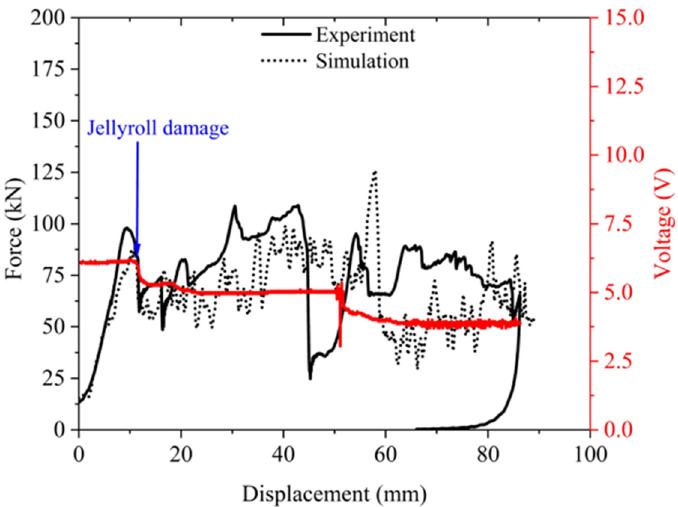
Figure 7. Force-displacement responses (black) and experimental voltage responses (red) obtained from experimental and FE model simulation for Case 1H (50 mm/s higher speed indentation of battery module along x direction with wedge edge parallel to z direction).